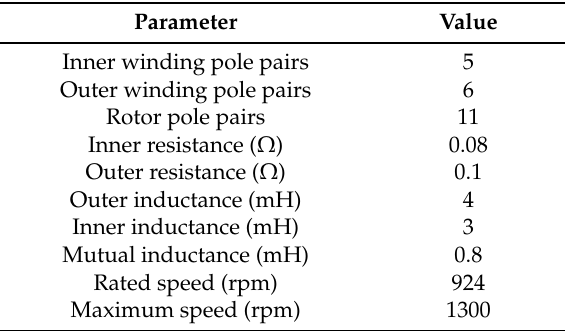
Figure 5. Prototype of the DSFM motor and its controller: ( a ) test machine; and ( b ) back-to-back controller. Table 1. DSFM motor prototype parameters and ratings. Table 1. DSFM motor prototype parameters and ratings.